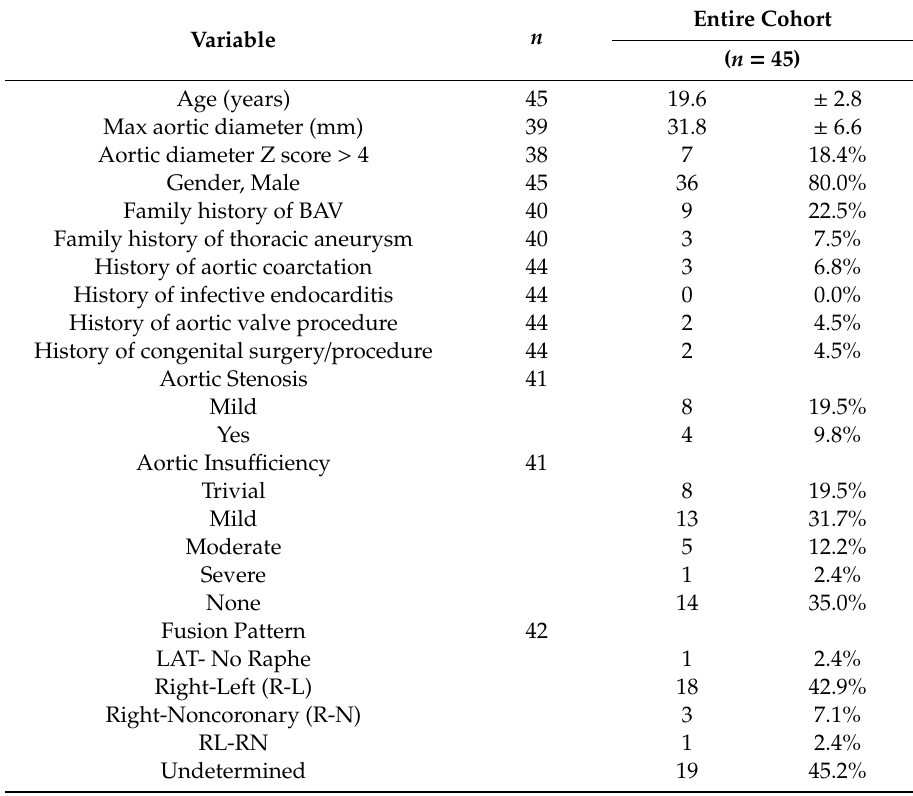
Table 3. Baseline Characteristics of Patients Presenting to BAV Bridge Transition